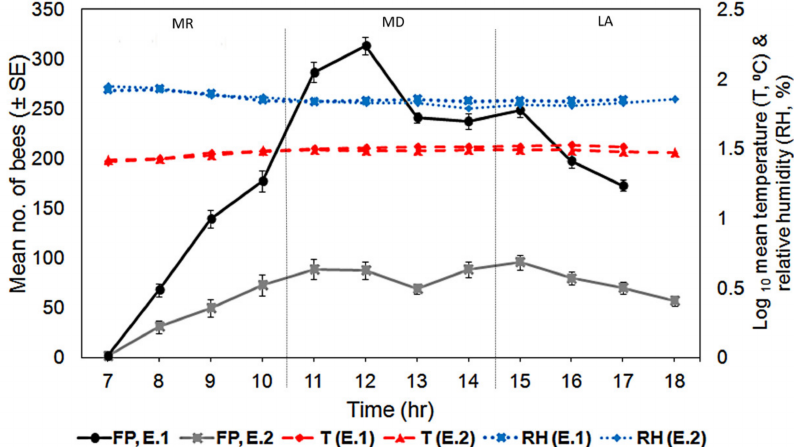
Figure 7. Foraging pattern (FP) of Heterotrigona itama based on the data collected in Experiment 1 (E.1; different concentration) and Experiment 2 (E.2; equal concentration). The experimental period for Experiment 1 was 11 h, while it was 12 h for Experiment 2 h at field. The red dashed lines indicate the mean temperature (T), and the blue dotted lines indicate the relative humidity (RH) of E1 and E2. (E.1: MR; T: 30.45 ± 0.43 ◦ C, RH: 71.28 ± 2.24%; MD: T: 31.22 ± 0.83 ◦ C, RH: 70.25 ± 2.87%; LA; T: 31.11 ± 0.82 ◦ C, RH: 71.04 ± 3.42%. E.2: MR; T: 28.00 ± 0.41 ◦ C, RH: 74.13 ± 1.44%; MD: T: 30.54 ± 0.48 ◦ C, RH: 70.88 ± 1.47%; LA; T: 30.51 ± 0.52 ◦ C, RH: 74.61 ±